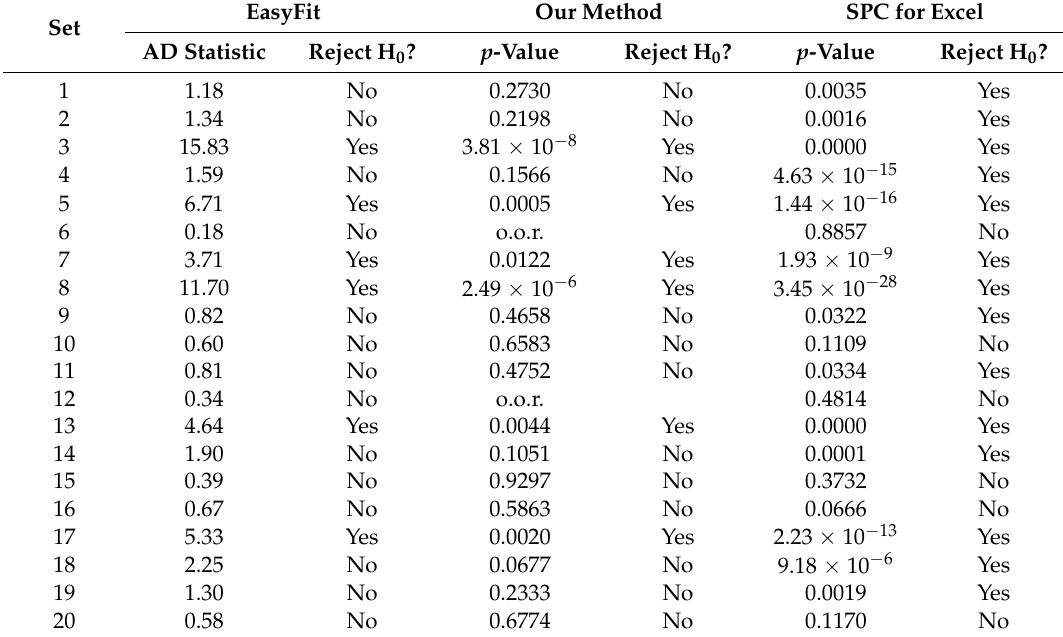
Table 10. Anderson–Darling (AD) statistic, associated p -values, and test conclusion: comparisons. EasyFit Our Method SPC for Set